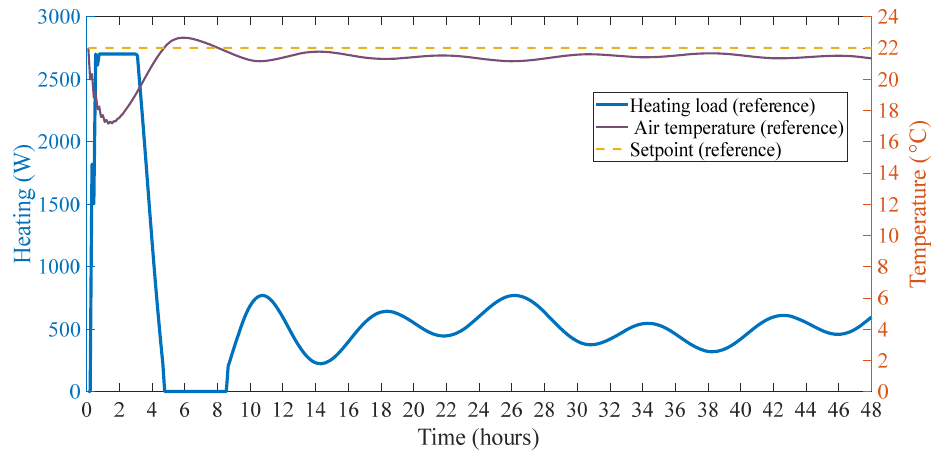
Figure 11. Refence case for air temperature control.